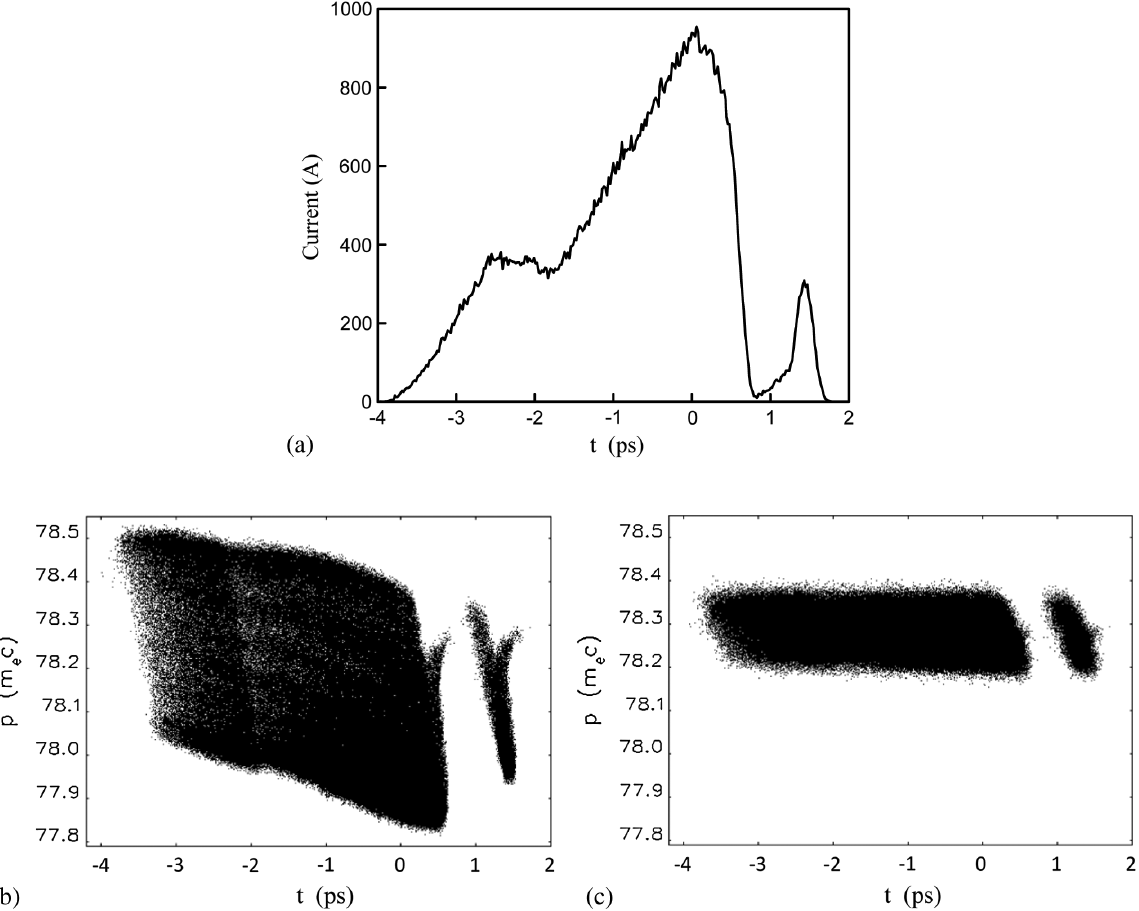
FIG. 9. Output beam current simulated in Elegant using the kicks method demonstrating aberrations caused by accounting for both the LSC effect and the CSR effect in the bends (a). Longitudinal phase space of the output beam produced by each of these effects separately: (b) for CSR, (c) for LSC. The corresponding beam charge before the mask was 5 nC in all